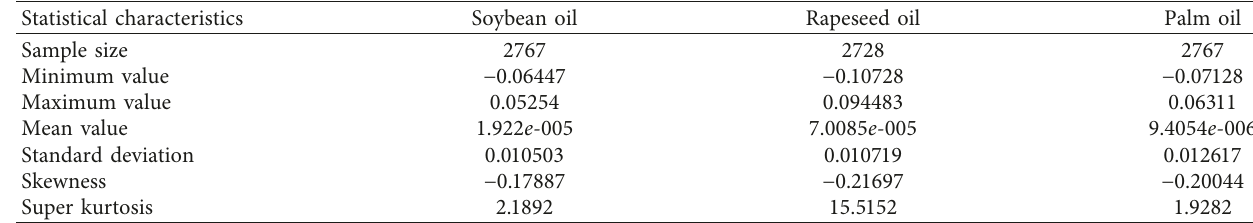
Table 1: Daily returns observations descriptive statistics.